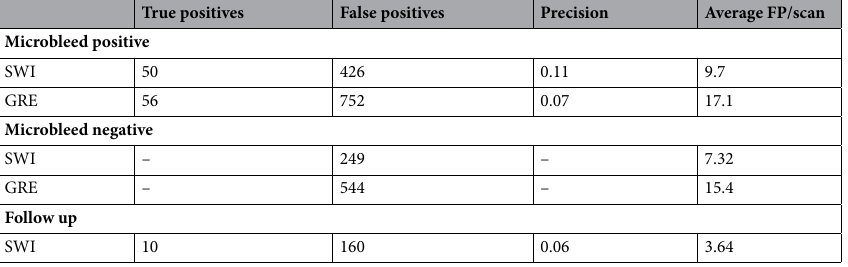
Table 3. Algorithm precision results. As noted in the methods, microbleed positive participants are those who have at least one microbleed present (identified by two or more raters), and microbleed negative participants are those who have no microbleeds present (agreed by all three raters). False positive (FP) are presented in the final column averaged over the number of images